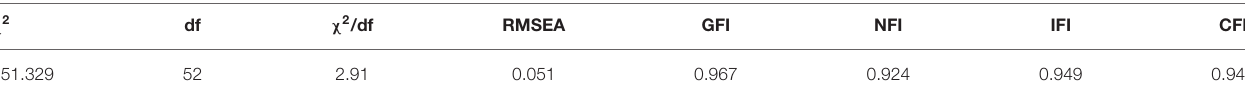
TABLE 3 | Fitting index of intermediary